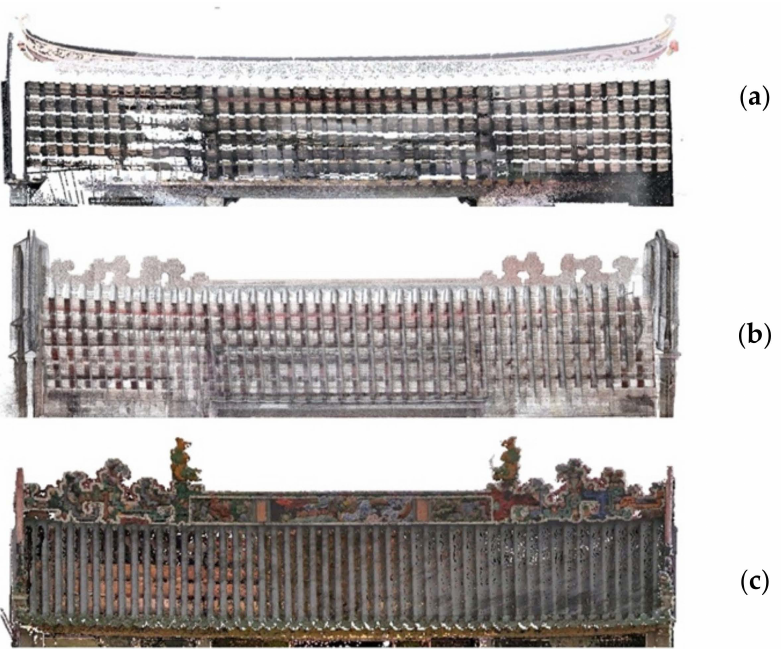
Figure 9. Roof of ancestral halls. The three types of roofs include: ( a ) boat ridge; ( b ) antique ridge; ( c ) pottery